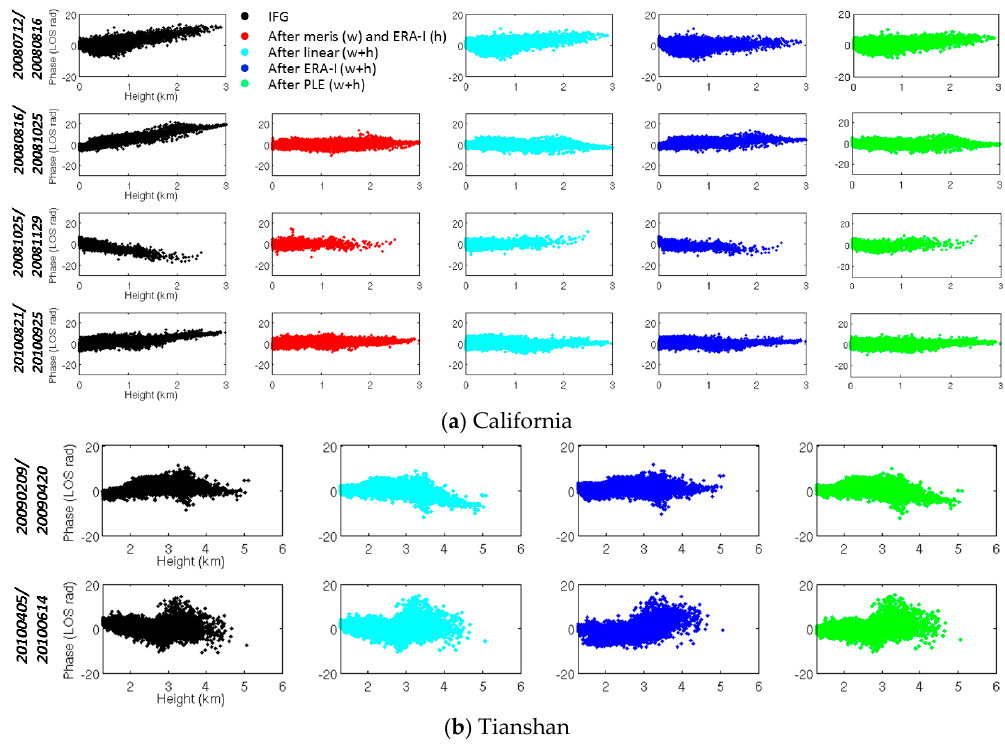
Figure 12. Examples of final results after different tropospheric corrections in: ( a ) California; and ( b ) Tianshan. MERIS delays contain hydrostatic delay component from ERA-I.